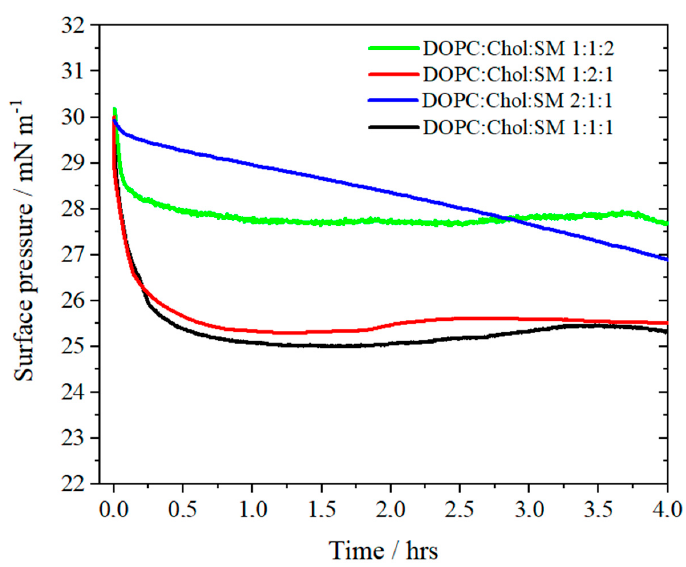
Figure 5. The surface pressure vs. time plots for DOPC:Chol:SM 1:1:2 (green), DOPC:Chol:SM 1:2:1 (red), DOPC:Chol:SM 2:1:1 (blue) and DOPC:Chol:SM 1:1:1 (black) Langmuir monolayers compressed to 30 mN/m on PBS buffer, pH 7.4 (T = 21 ± 1 °C).